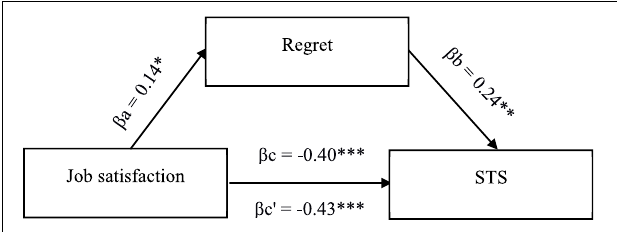
FIGURE 3 | Model of associations between job satisfaction, cognitive coping strategy in the form of regret, and STS. β a,b, indirect effect; β c, total effect; β c’, direct effect; * p < 0.05; ** p < 0.01; *** p <